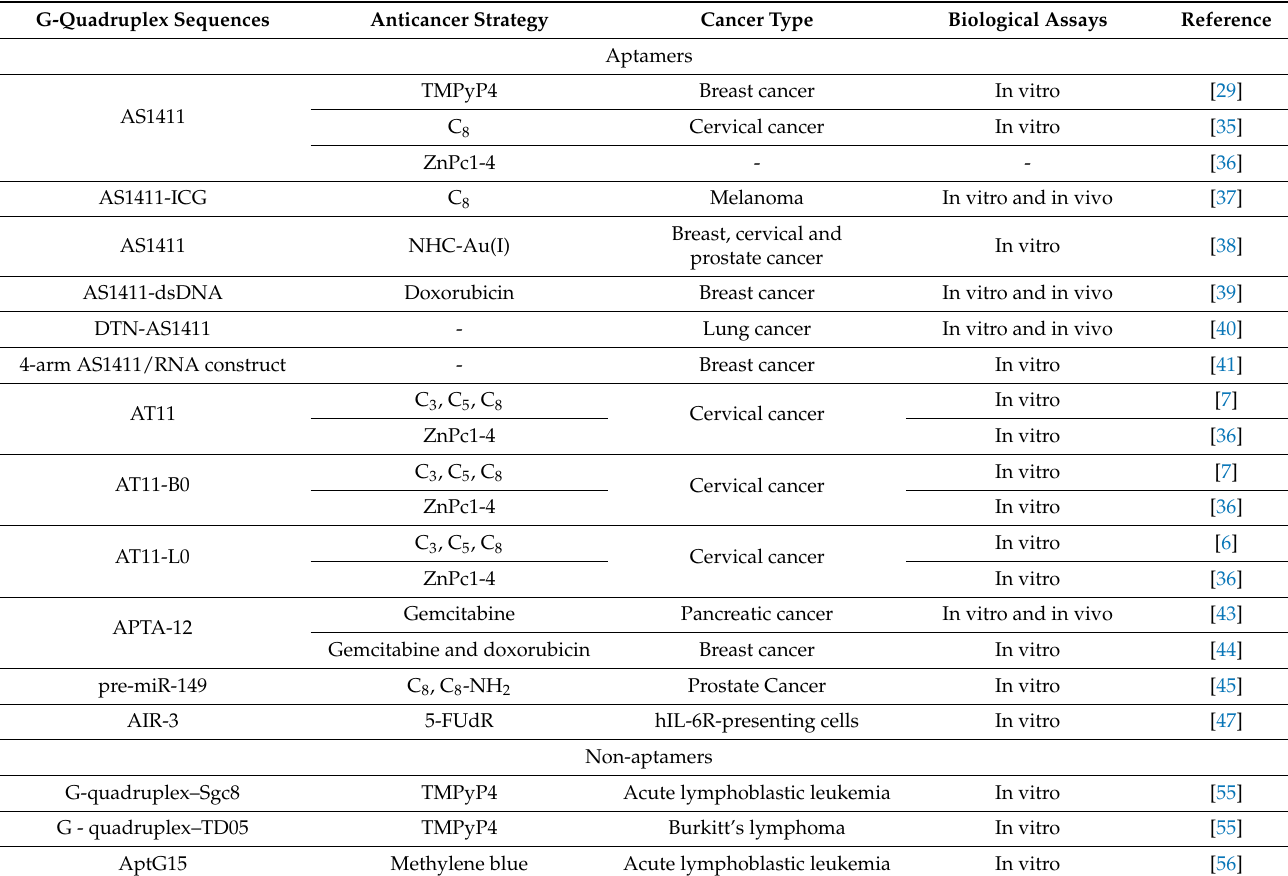
Table 1. G4 sequences strategies and biological assays used to analyze the anticancer